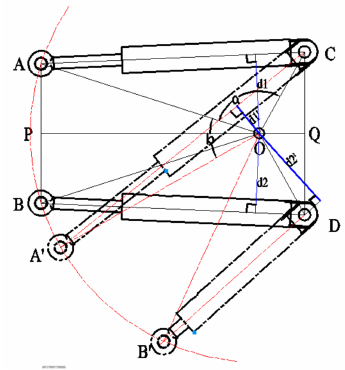
Figure 3. Steering geometry of an